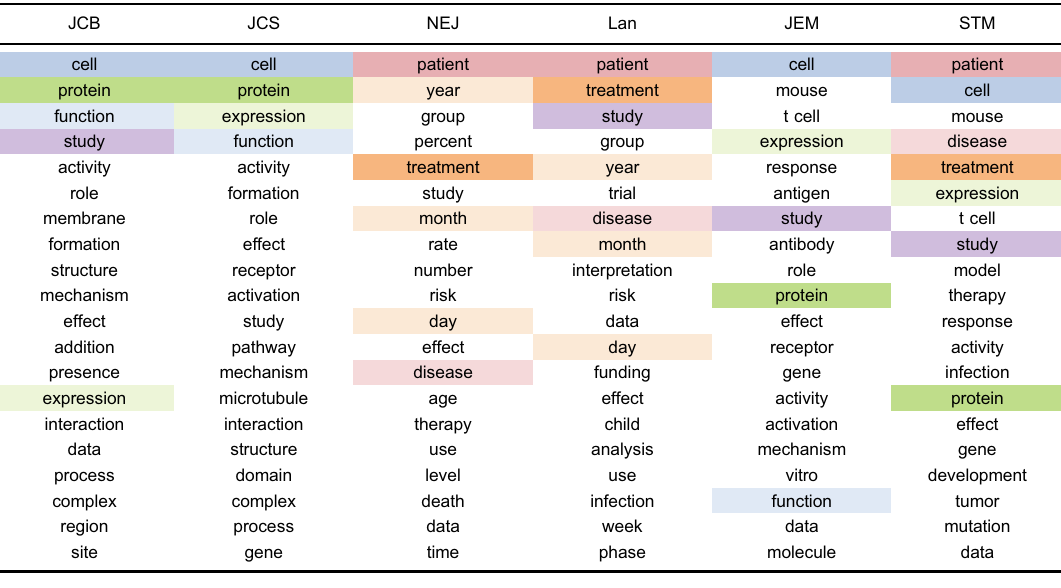
The table only depicts the 20 most frequent words, while the complete data are available in Supplementary Table S1. Color- coded cells represent the same word in different journals. JCB: Journal of Cell Biology; JCS: Journal of Cell Science;